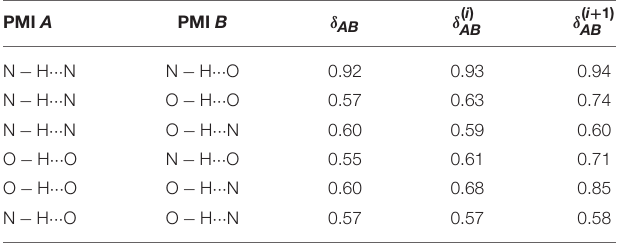
TABLE 1 | Probabilities that two PMIs corresponding to different hydrogen bond flavors agree that a point is a hydrogen bond (Equation 6).